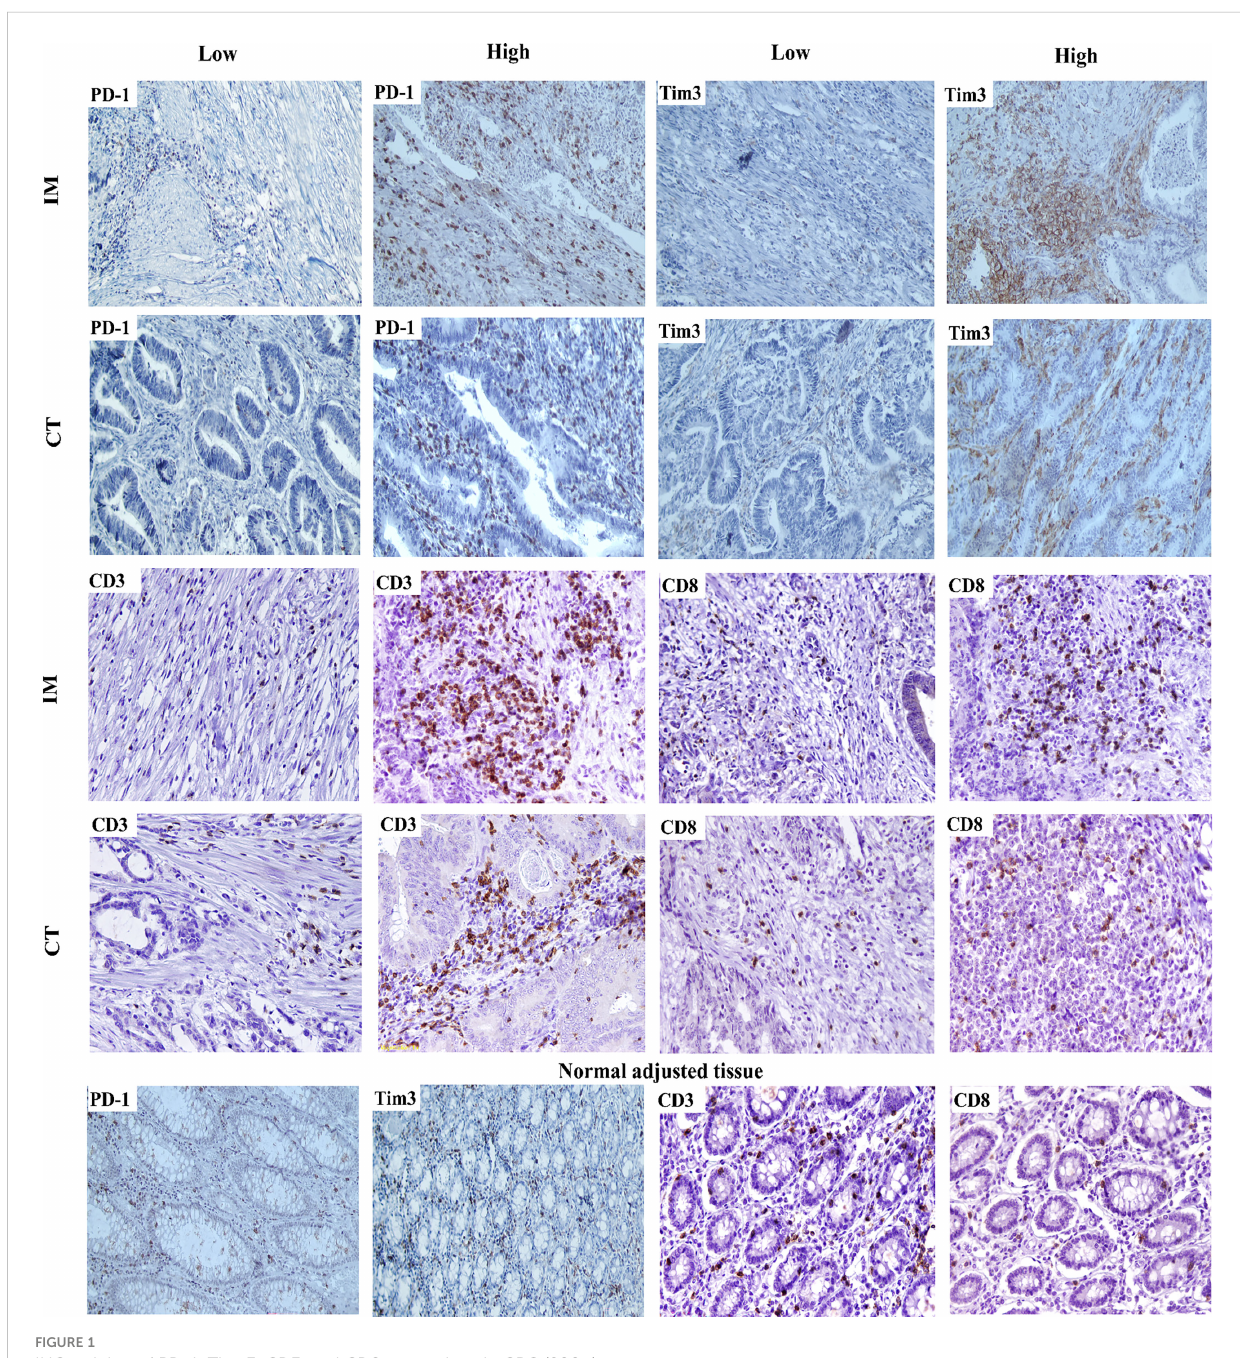
FIGURE 1 IHC staining of PD-1, Tim-3, CD3, and CD8 expressions in CRC